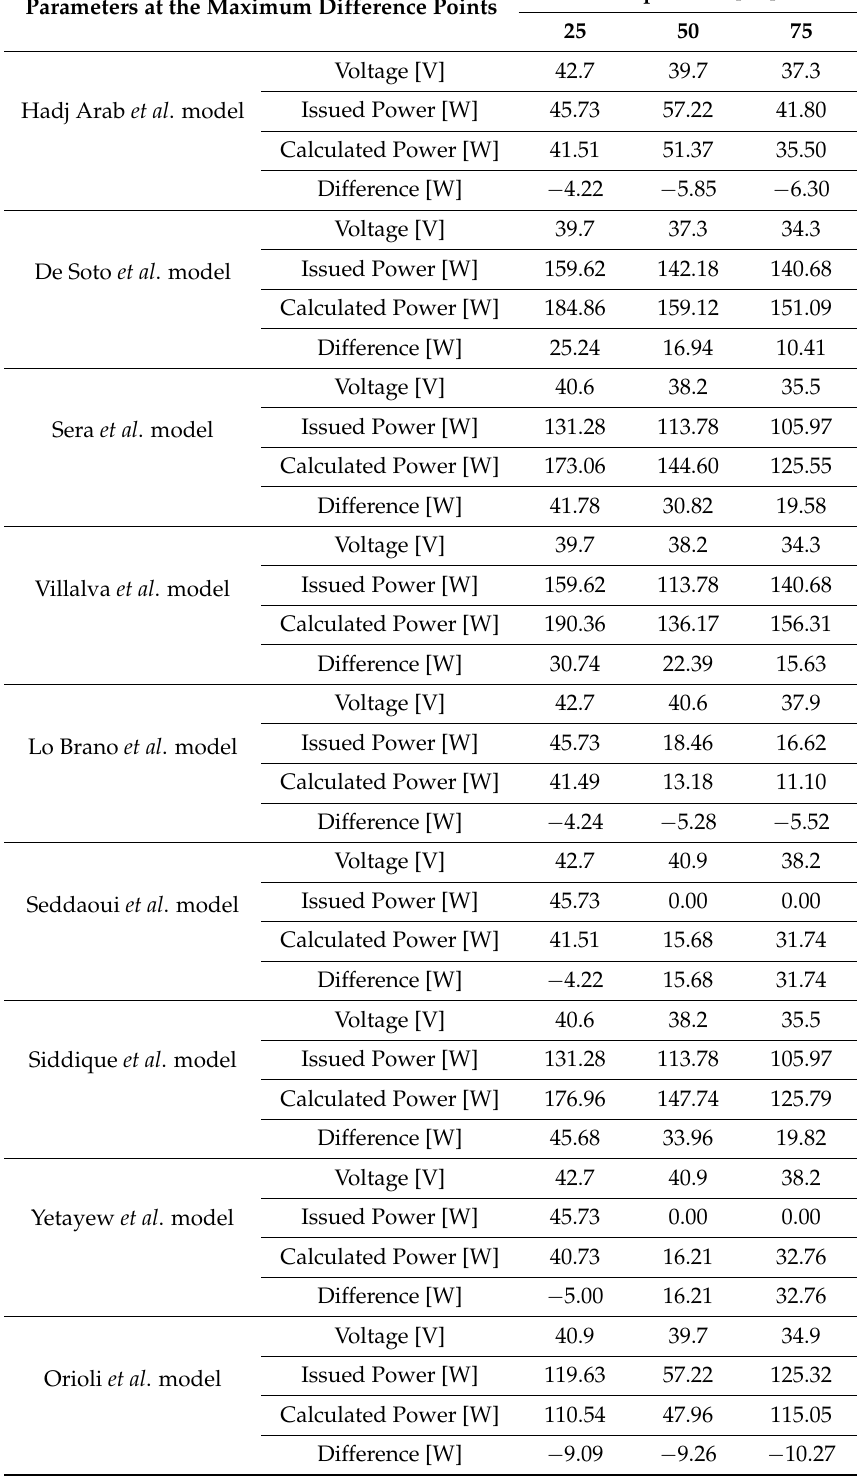
Table 14. Maximum power differences between the calculated and the issued I-V characteristics of Sanyo HIT-240 HDE4, at irradiance G = 1000 W/m 2